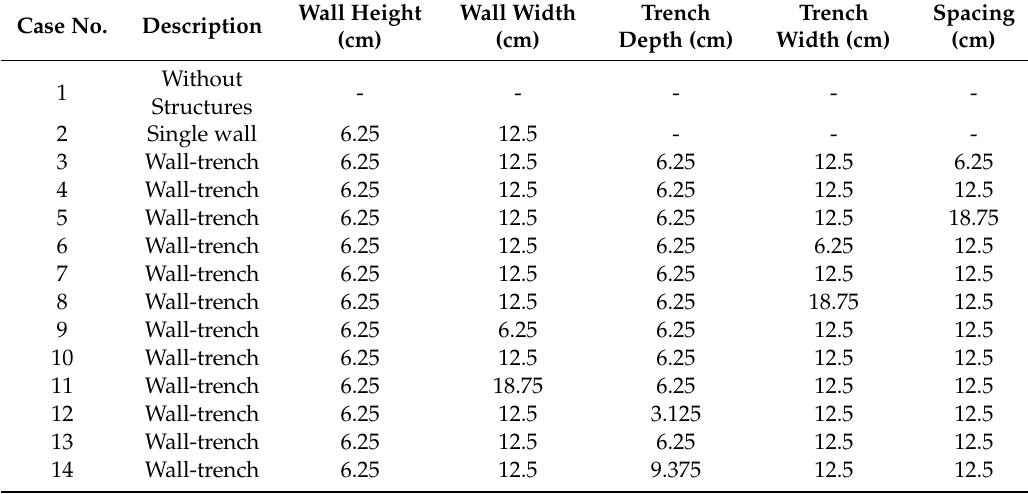
Table 2. Description of simulation cases with details of onshore structures (in real